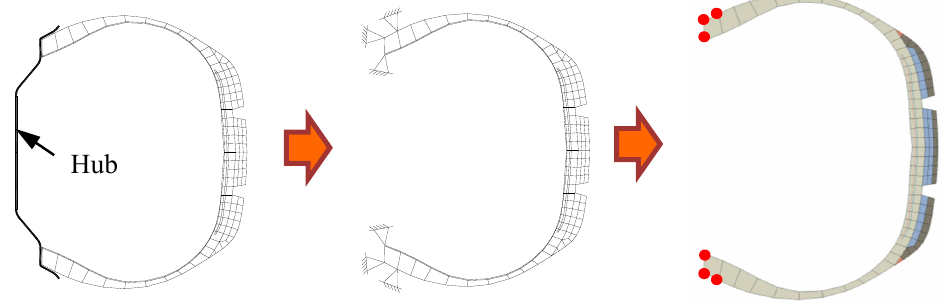
Figure 3. Simplification of contact conditions between tire bead and wheel hub.